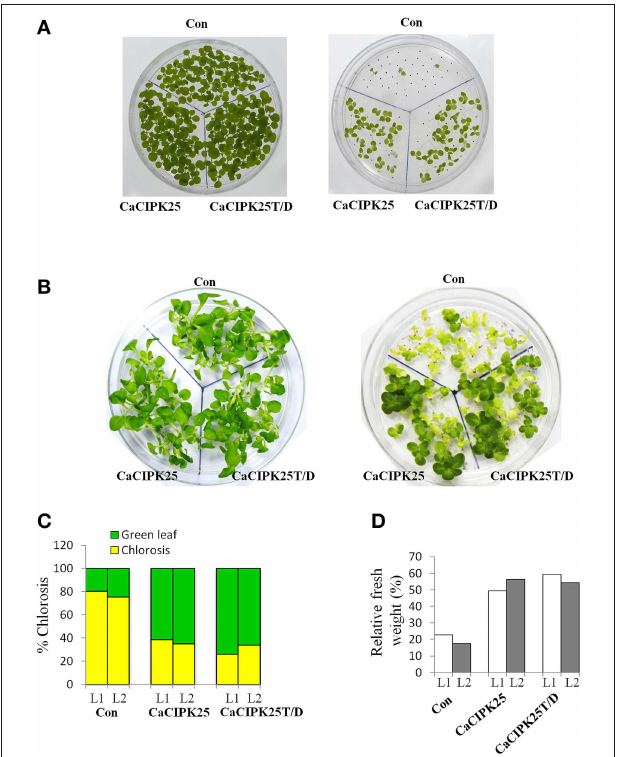
FIGURE 7 | Effect of salt stress on transgenic tobacco seedlings. (A) Control (vector only), CaCIPK25- and CaCIPK25T/D- expressing tobacco seeds were germinated on media without (left) and with (right) 200mM sodium chloride for 15 days. (B) 8-day-old seedlings of control, CaCIPK25 − and CaCIPK25T/D-expressing lines were transferred to media without (left) and with (right) 250mM sodium chloride for 10 days and then transferred to normal medium for 8 days. (C) Leaves of the seedlings of two representative transgenic lines (L1 and L2) exposed to salt were scored for chlorosis and bleaching and presented as relative to total number of leaves. (D) Fresh weights of the seedlings from the same experiment were presented relative to the fresh weights of corresponding seedlings grown in normal medium for the same period.